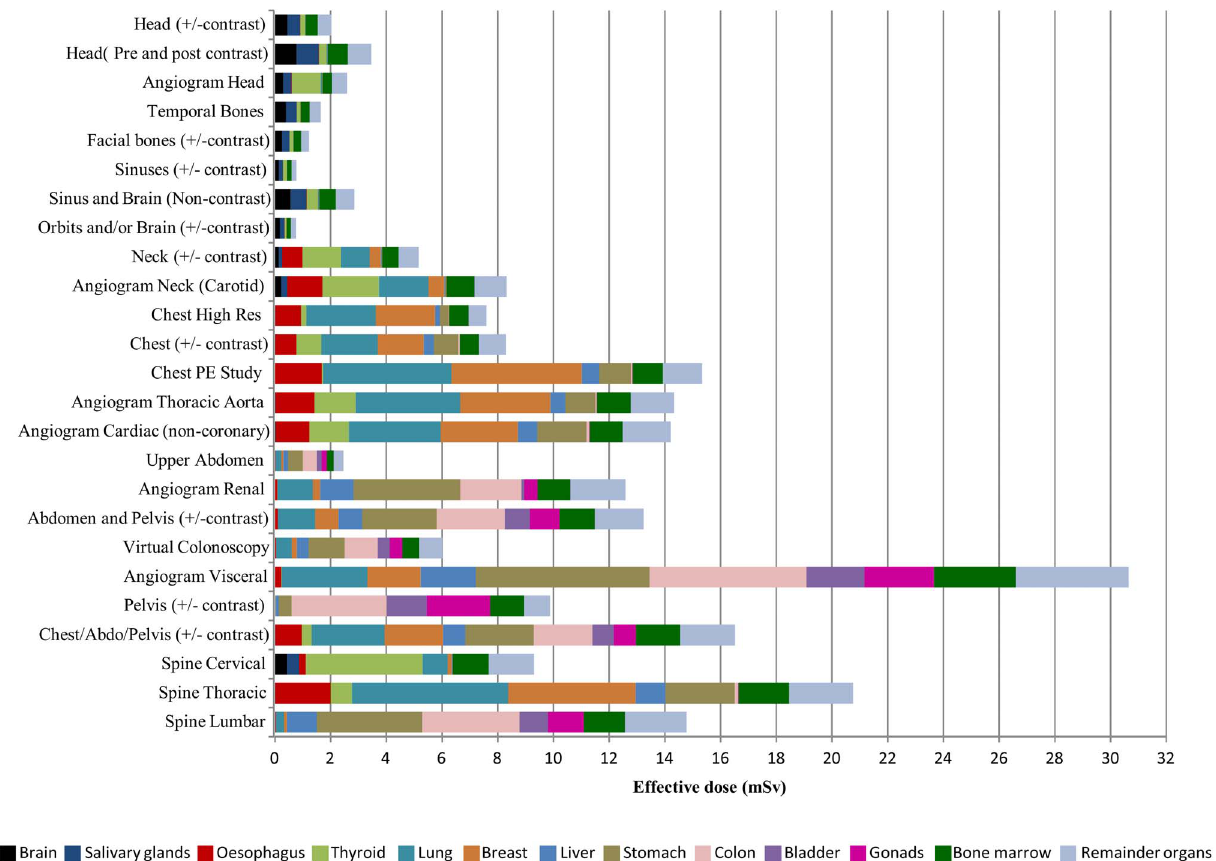
Figure 1. Mean whole body and organ specific effective doses (mSv) for selected CT scanning examinations performed in a Western Australian tertiary public hospital in 2011.